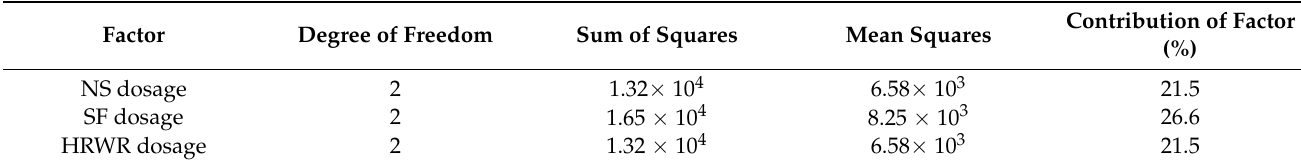
Table 8. Analyses of variance (ANOVA) for yield stress.